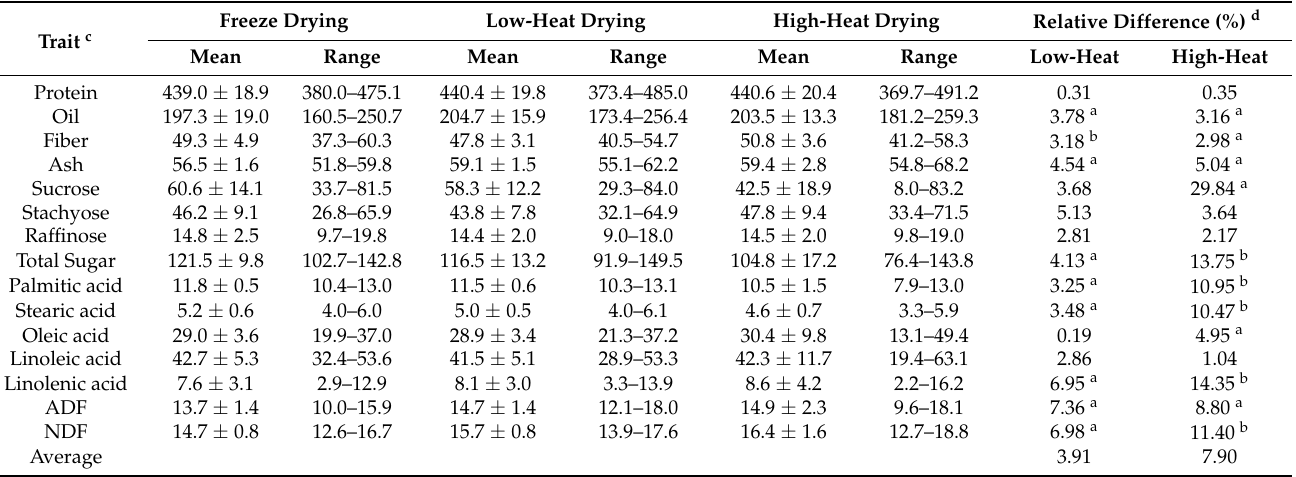
Table 6. Means ( ± sd) and ranges of variation of seed composition traits in ground samples of edamame dried by freeze, low-heat and high-heat drying methods and over three years